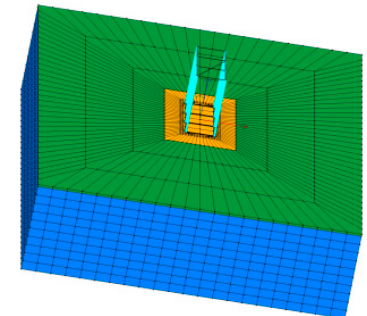
Figure 3. Mesh 2: soil–structure interaction (SSI) model; uniform soil layer (blue), infill (green) and foundation (yellow) [27].